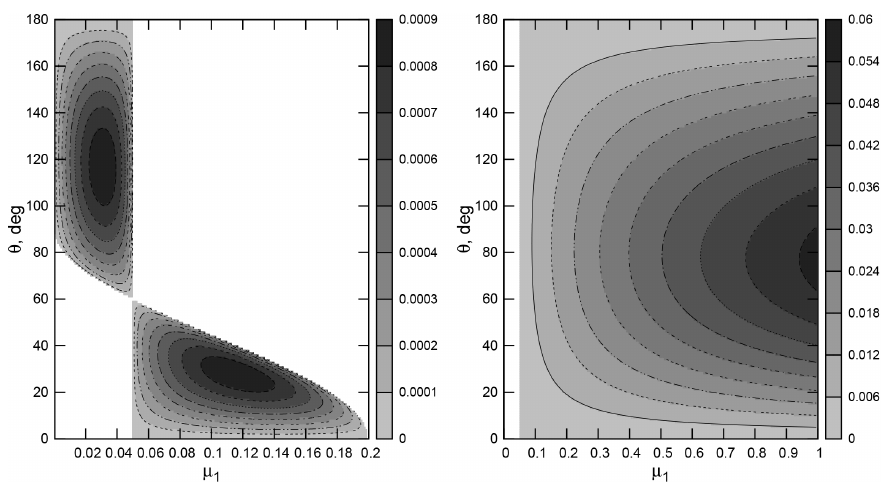
(cid:12) (cid:12) (cid:12)(cid:1) as a function of µ 1 and θ for small perpendicular wavenumber of the pump wave (cid:12) e(cid:56) p /T e